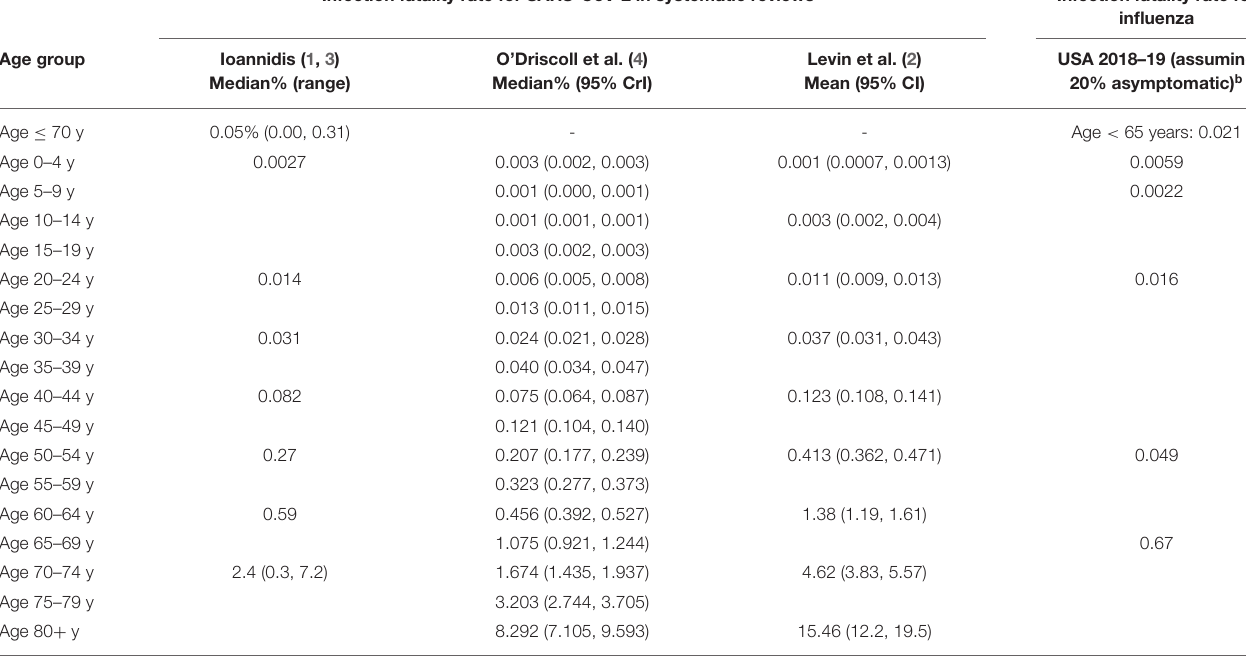
TABLE 1 | SARS-CoV-2 age-specific infection fatality rates compared to infection fatality rates from Influenza in the United States. Infection fatality rate for SARS-CoV-2 in systematic reviews a Infection fatality rate for